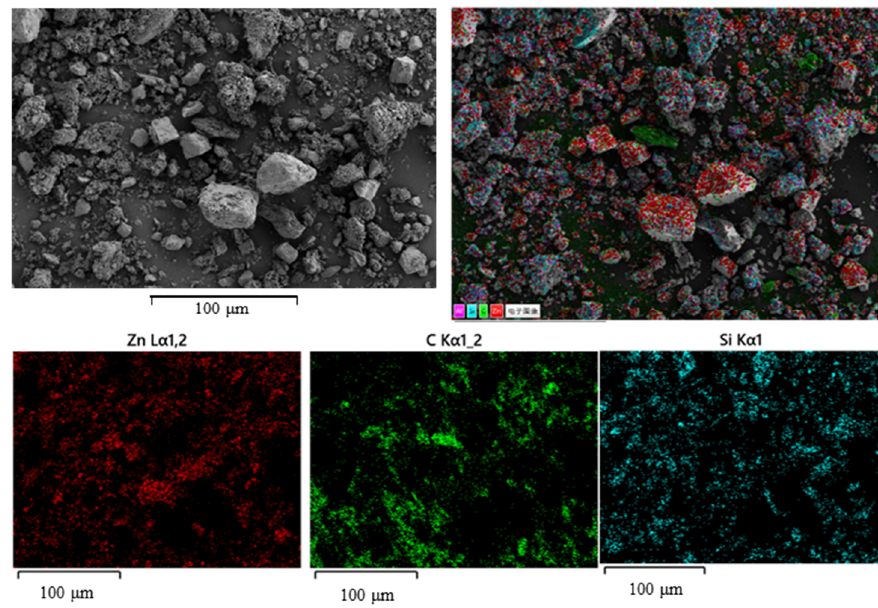
Figure 13. SEM-EDS pictures of flotation concentrate of the mixed mineral of smithsonite- kaolinite.